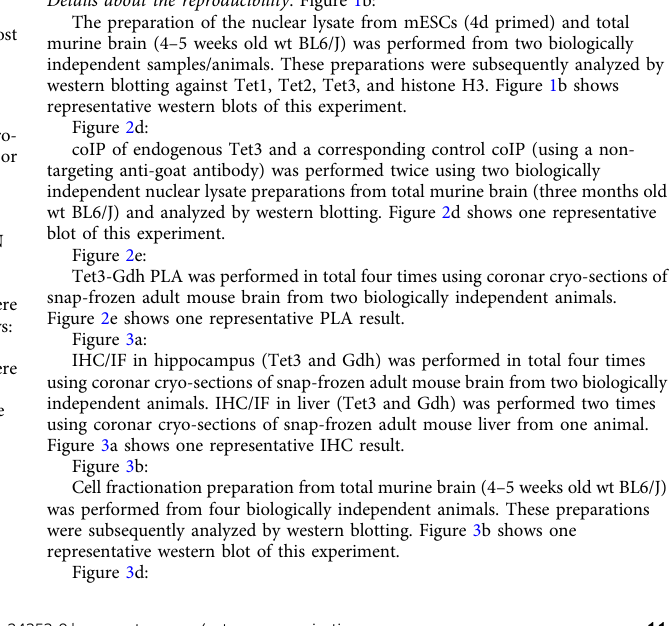
Supplementary Fig. 5d: For each sample ( n = 3 biologically independent samples), hmdC/dN and fdC/